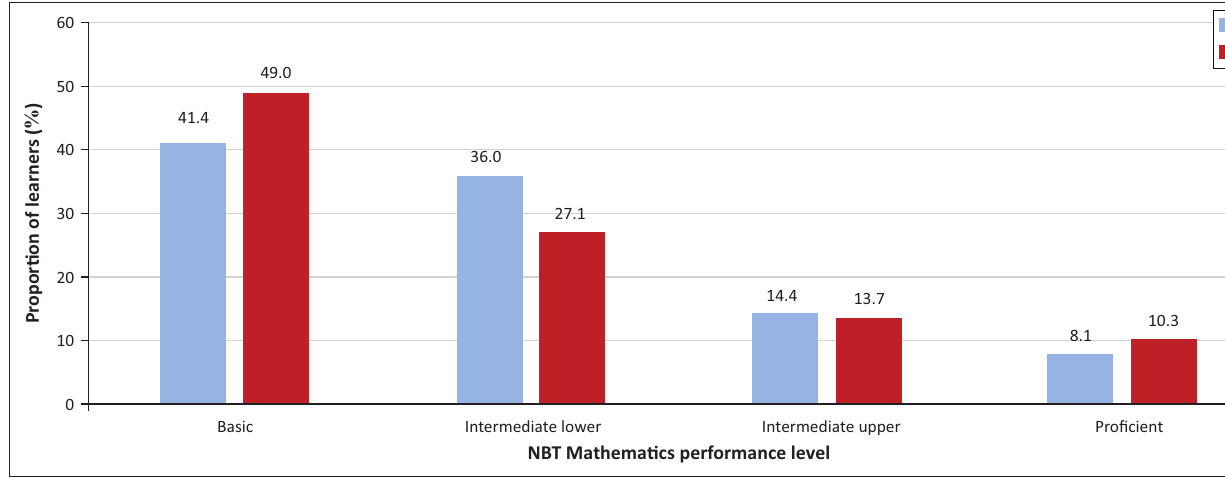
FIGURE 1: Proportion of learners within NBT Mathematics performance levels for NBT 2012 and 2013 intake